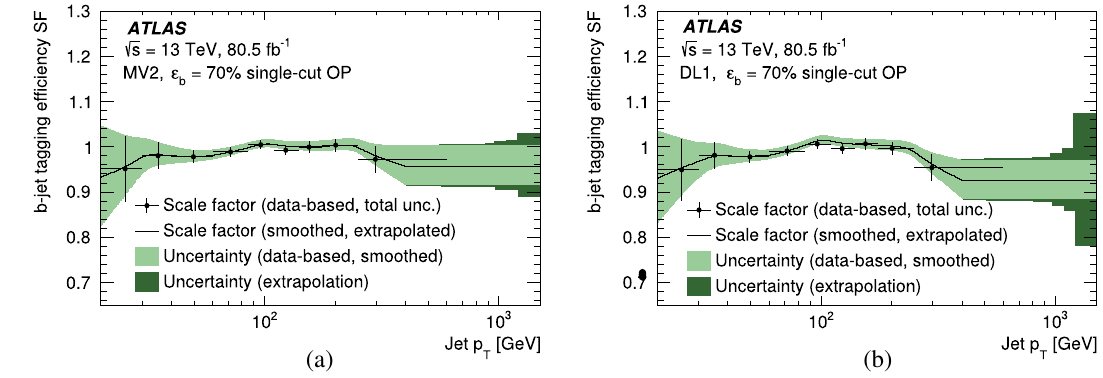
Fig. 12 b -jet tagging efficiency simulation-to-data scale factors for the ε b = 70% single cut OP of the (a) MV2 and (b) DL1 taggers, including the smoothed and extrapolated results. The bin centres are used for the smoothing whereas the dots are located at the mean of the b -jet p T distribution in each p T